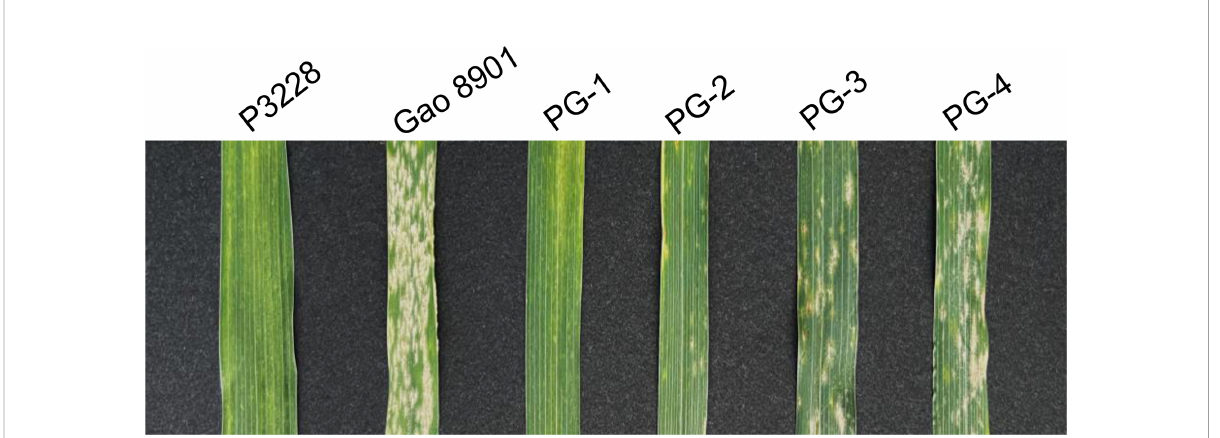
FIGURE 1 Phenotypic characterization of resistance to powdery mildew at the adult stage in two parents and some representative RILs. P3228, PuBing 3228; PG-1, PG-2, PG-3, and PG-4 are representative lines in PG-RIL